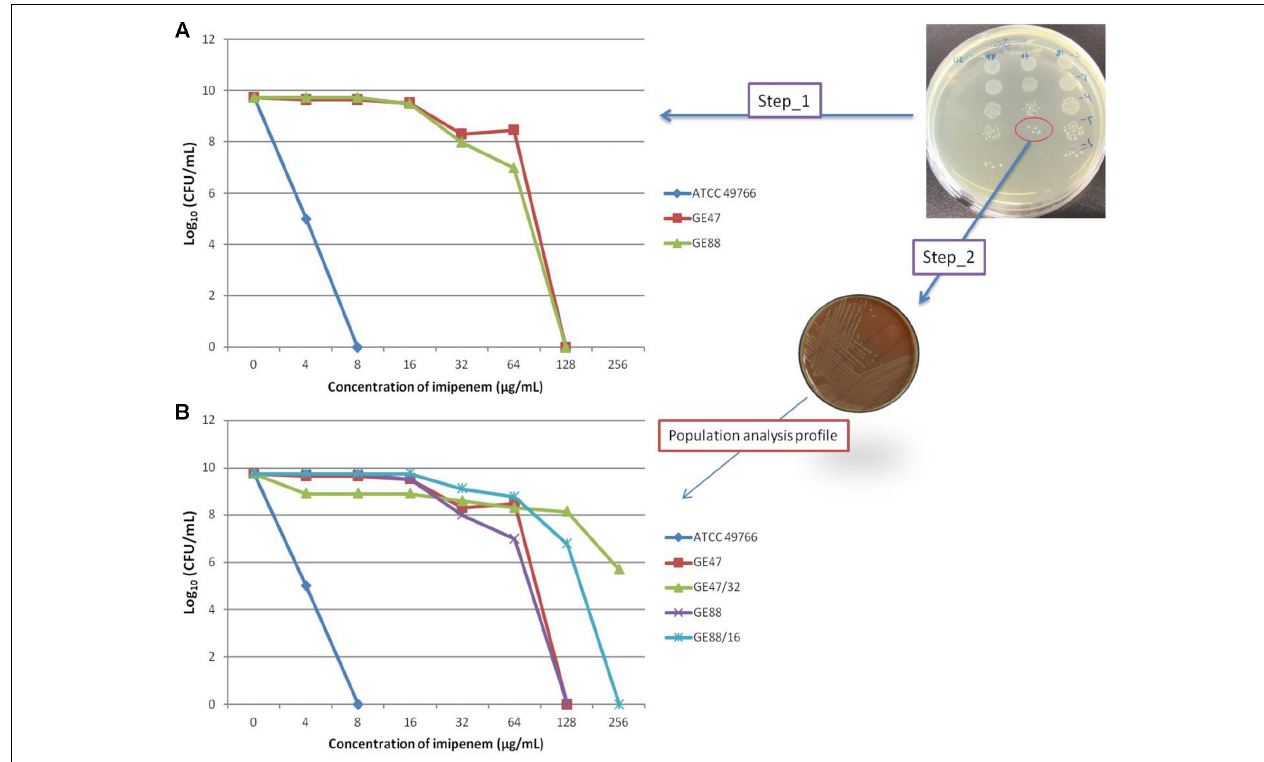
FIGURE 2 | (A) Population analysis profiles of GE47 and GE88 strains as determined by microdilution plate counts. Haemophilus influenzae ATCC 49766 strain was used as a negative control for all experiments. (B) One colony of each of two NTHi strains was picked from HTM agar containing 16 or 32 µ g of imipenem/mL and passaged in imipenem free HTM agar. After overnight growth, these cultures were named GE47/32 and